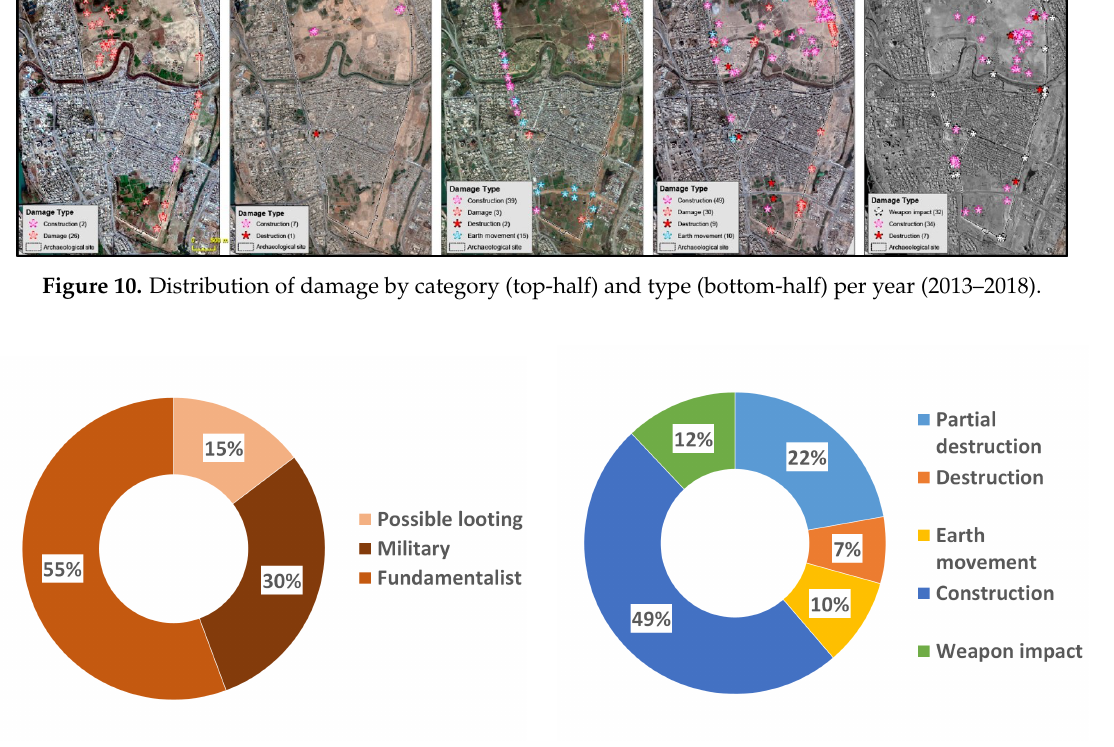
( a ) Damage per category. ( b ) Damage per type. Figure 11. Distribution of damage in the overall period (November 2013–March